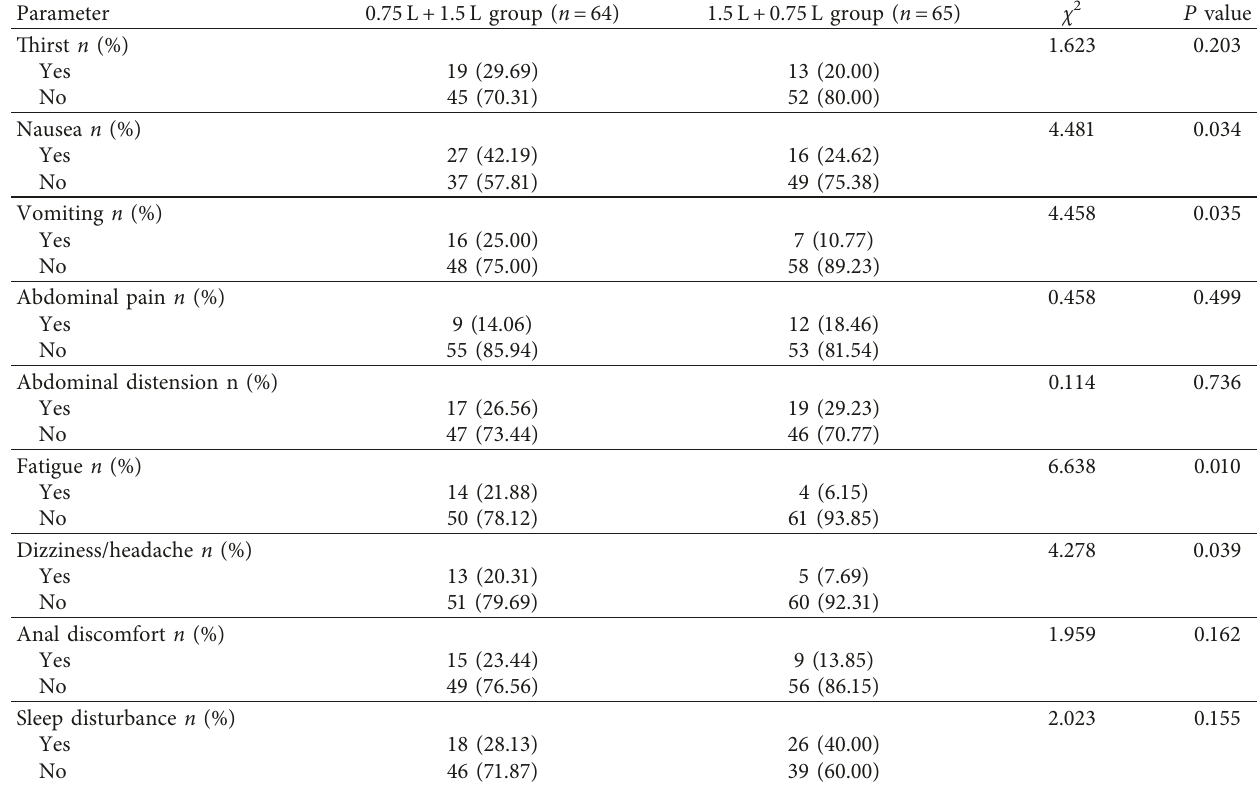
Table 3: Tolerability of bowel preparation in patients undergoing